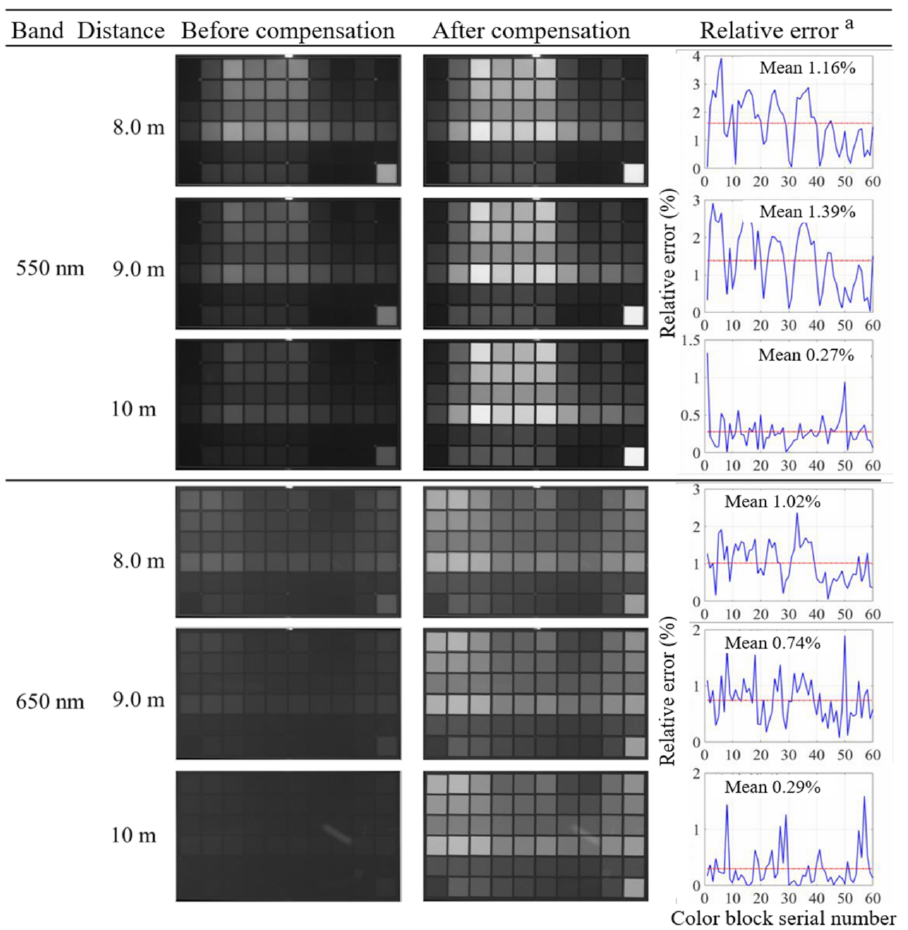
Figure 13. Example of the spectral images at different distances uniformly compensated to 7 m using water attenuation compensation. ( a Relative error of varying color